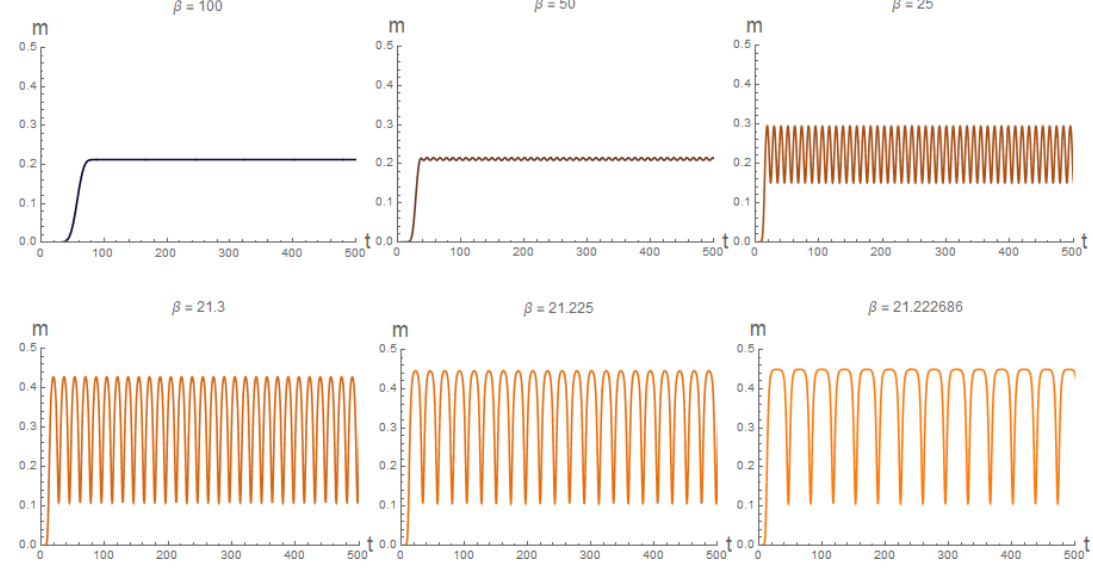
Figure 13 . Evolution of m for di(cid:11)erent build-up processes for a driving characterized by ! b = 2, (cid:15) = 0 : 09. From top-left to right bottom, the build-up time (cid:12) decreases as shown in the plots.